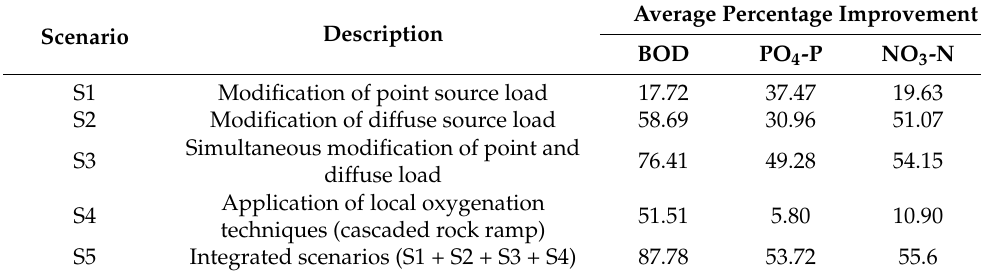
Table 5. Average percentage constituent improvement for various hypothetical pollution reduction scenarios in